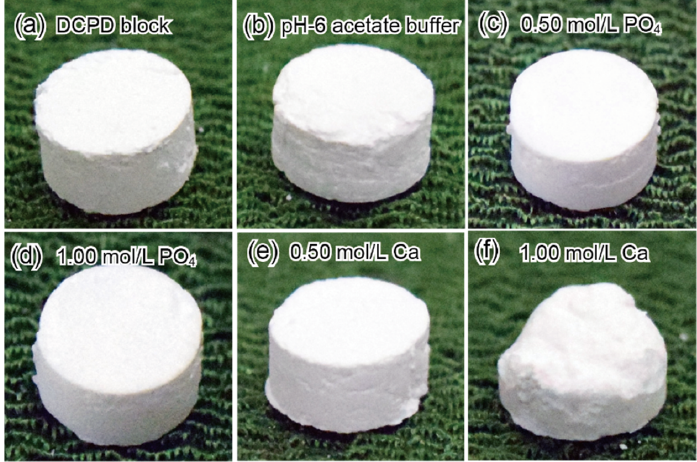
Figure 1. Photographs of the dicalcium hydrogen phosphate dihydrate (DCPD) block ( a ) before immersion, and after immersion in a ( b ) pH-6 acetate buffer, ( c ) 0.50 mol/L PO 4 solution, ( d ) 1.00 mol/L PO 4 solution, ( e ) 0.50 mol/L Ca solution, and ( f ) 1.00 mol/L Ca solution, all at 70 °C for 2 days.